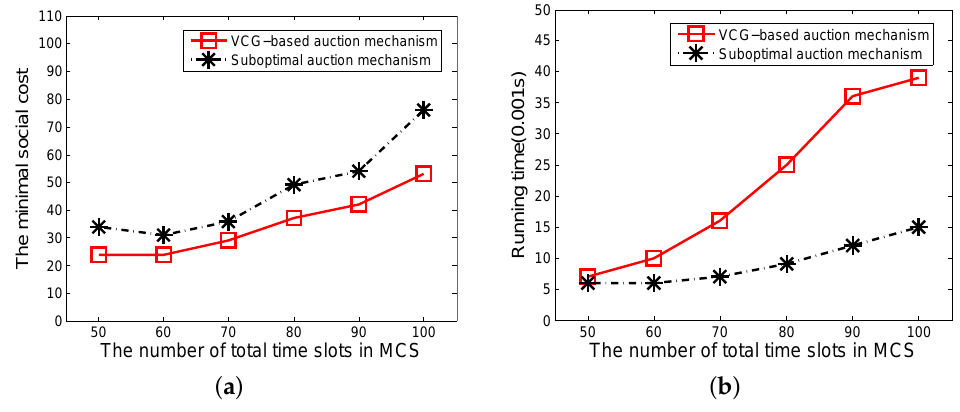
Figure 4. ( a ) The social cost of two auction mechanisms in continuous working pattern; ( b ) The running time of two auction mechanisms in continuous working pattern. VCG: